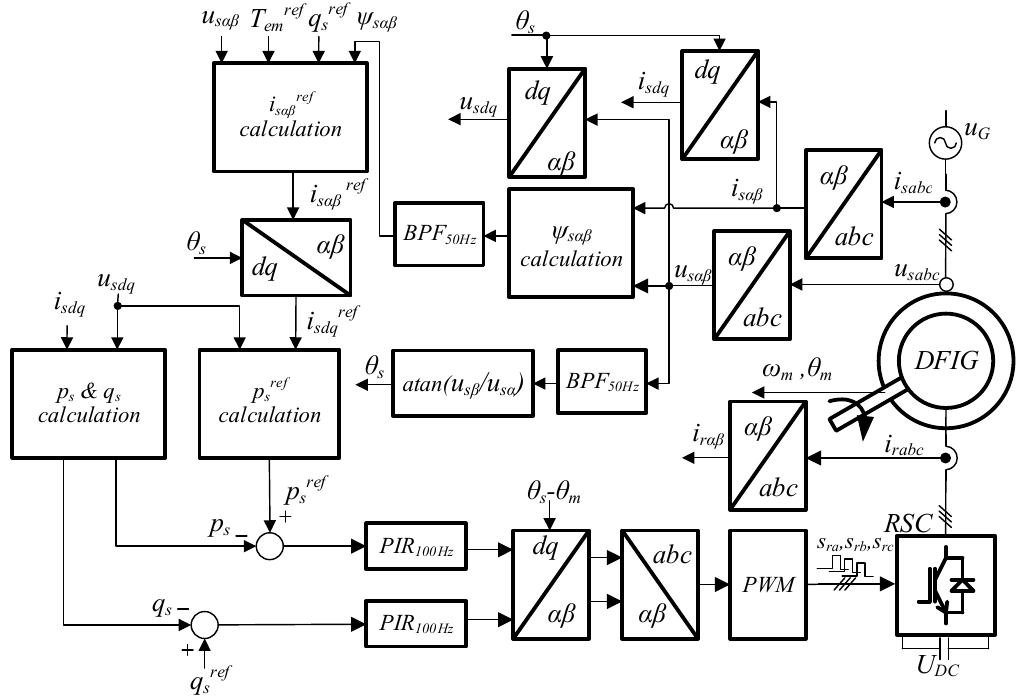
Figure 4. Direct power control of DFIG in the orthogonal synchronously rotating frame.